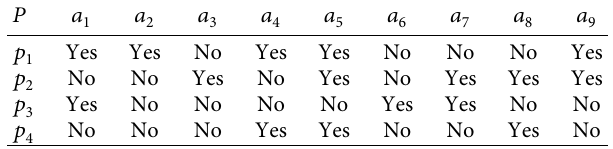
Table 7: Patients daily activities and lives.